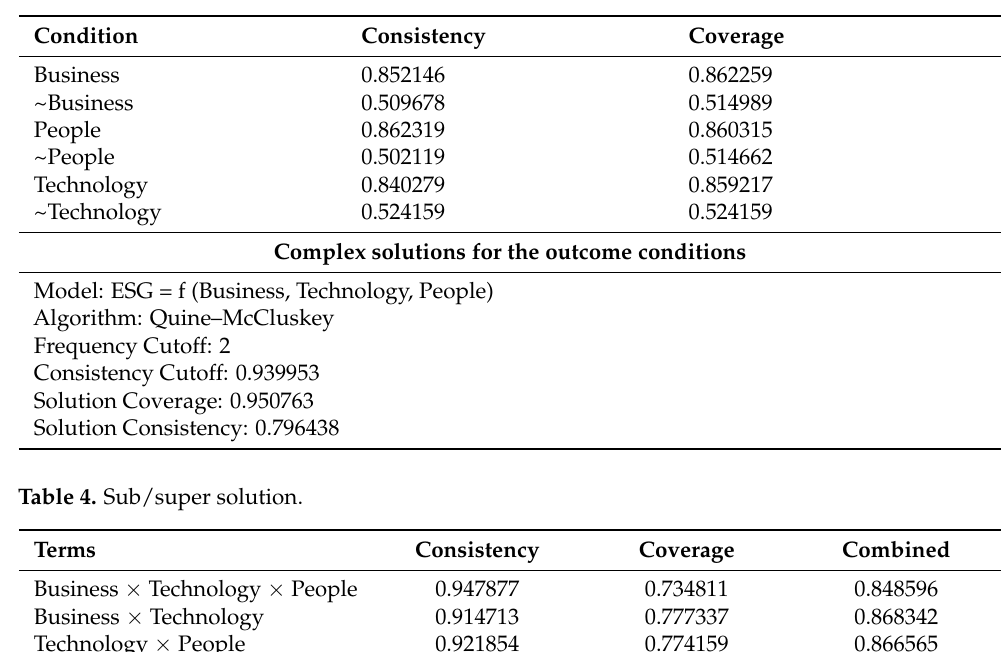
Table 3. Analysis of necessity and sufficiency.